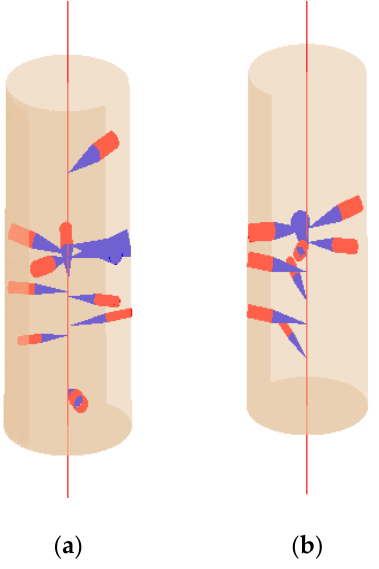
Figure 5. ( a ) Visual representation of log 1; ( b ) visual representation of log 2.